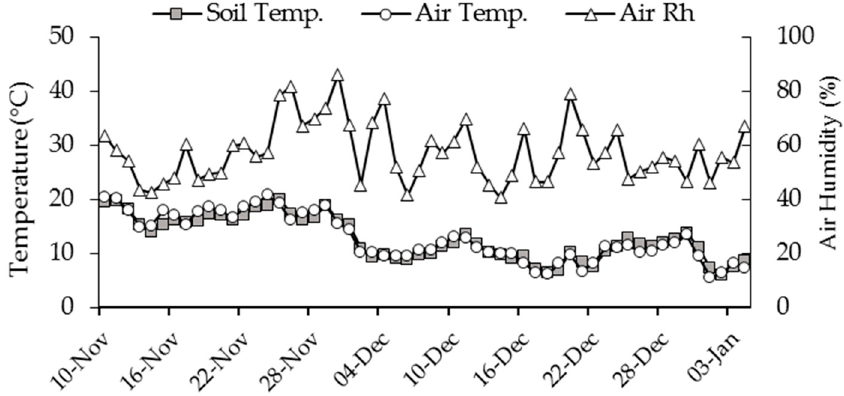
Figure 4. Environmental condition during cold experiment at seedling stage. 193